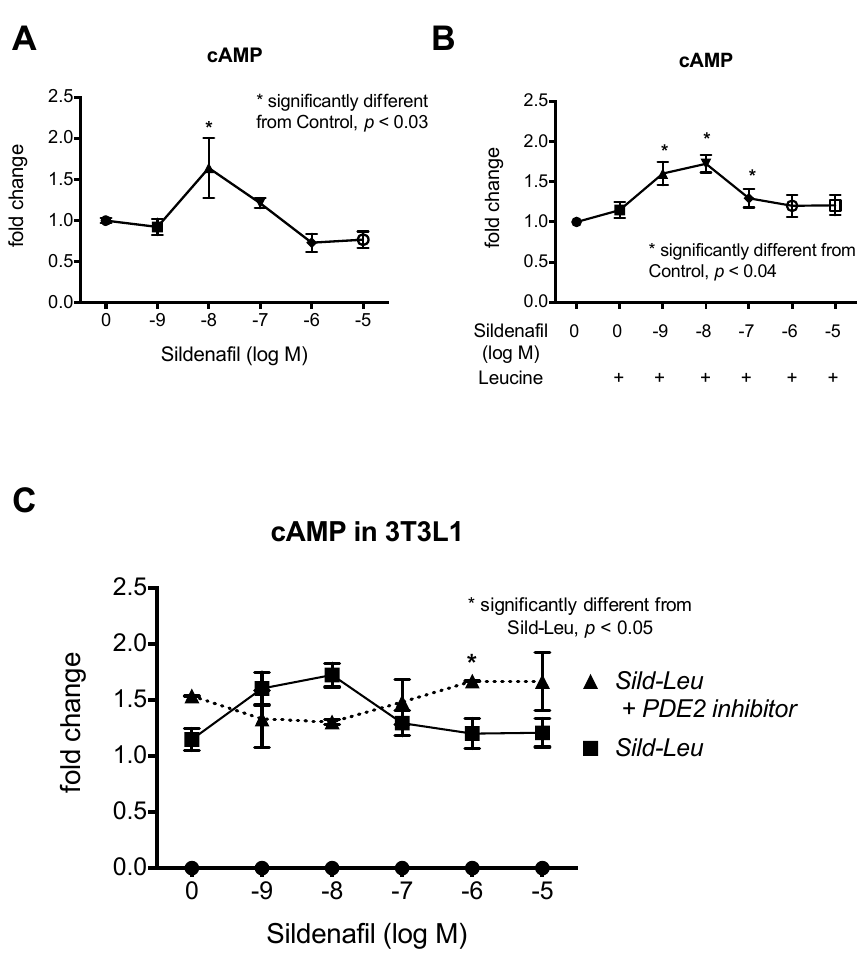
Figure 2. Effects of sildenafil and leucine on cAMP concentrations in 3T3L1 cells. cAMP response in 3T3L1 adipocytes treated with ( A ) sildenafil (1 nM to 10 µM) alone or ( B ) in combination with Leucine (0.5 mM) for 30 min. Data were calculated and statistically analyzed as a fold change of control and are expressed as means ± SEM ( n = 3 to 5, p ≤ 0.05) (absolute values for control means are 3.922 and 3.48 pmol cAMP/mg protein for Sildenafil and Sildenafil-Leucine, respectively). * indicates a significant difference from Control ( p < 0.04). ( C ) Comparison of cAMP response in 3T3L1 adipocytes treated with sildenafil-leucine +/ − PDE2 inhibitor (BAY 60-7550, 10 µM) for 30 min. * indicates significant difference between the two curves ( p < 0.05).